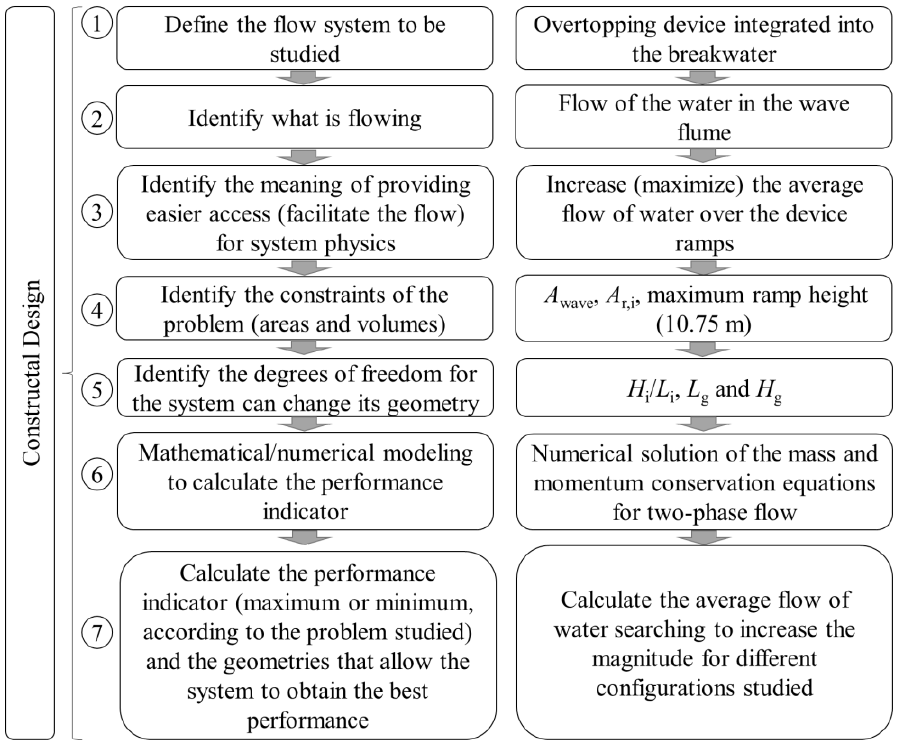
Figure 4. Diagram of the Constructal Design method applied to the problem. Regarding the simulation process, it was divided as illustrated in Table 2 and Figure 5, with three (3) simulations for the OTD-WEC with one ramp varying the degree of freedom H 1 / L 1 ratio in search of the maximum magnitude of the average overtopping dimensionless flow ( Q ) mm through the Equation (1) using Equation (5), as follows, to obtain the numerical value of Q